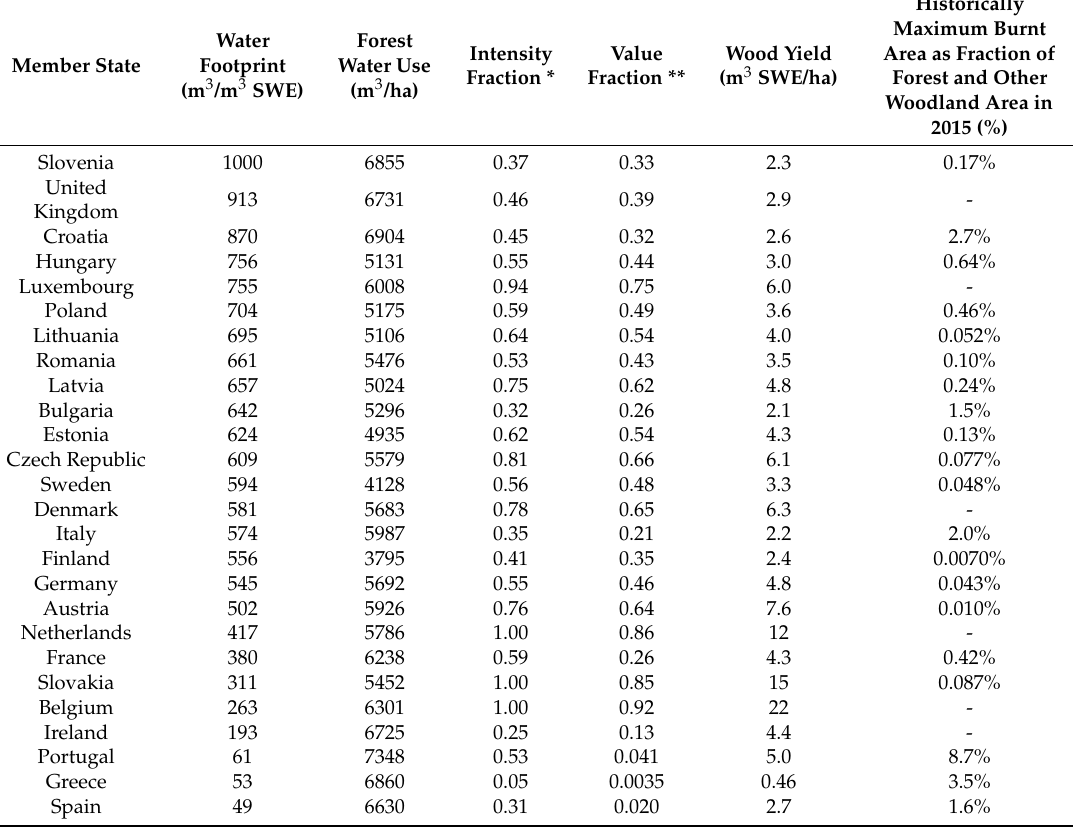
Table A1. The water footprint per unit of solid wood equivalent (SWE) in the EU-28 member states (period: 2001–2010; source: [16]) and the historically maximum burnt area (1990–2016) from the European Fire Database [62] as fraction of the total forest and woodland area in 2015